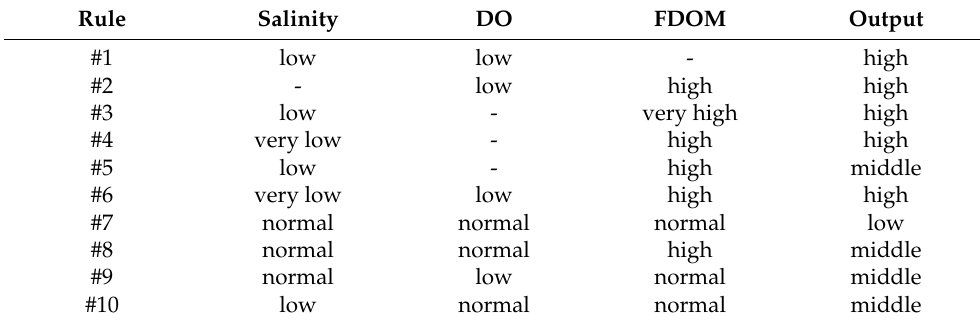
Table 4. Fuzzy rule base applied for SGD identification based on human expert